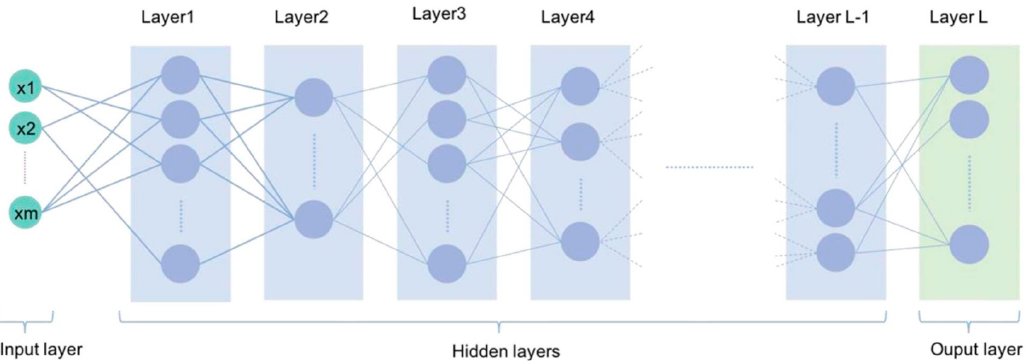
Figure 2. Illustration of a typical deep learning network with multiple layers between the input and output levels (acquired from [4]).